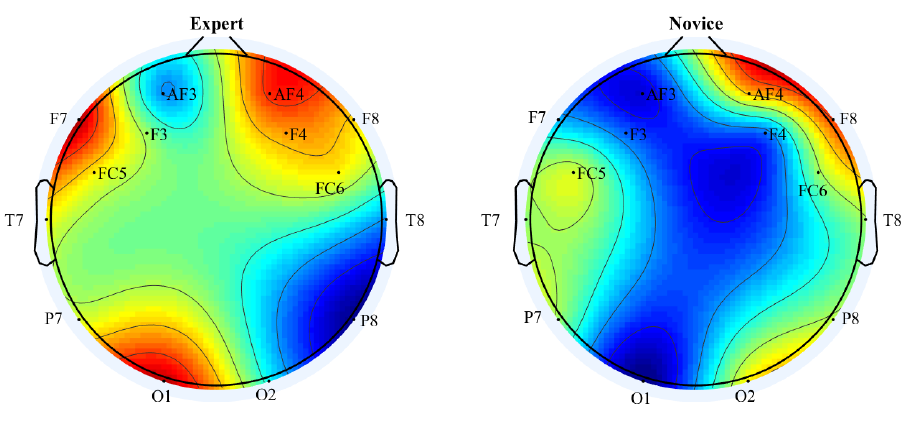
Figure 6. Brain visualization using the average power spectral density for an expert and a novice player. The brain maps are also visualized for the expert and novice player during the resting state. The results are shown in Figure 7. During resting periods, players were instructed to relax, and no mental task was performed. The baseline EEG is recorded with eyes open, and the brain maps show the corresponding activity on the frontal and occipital regions.